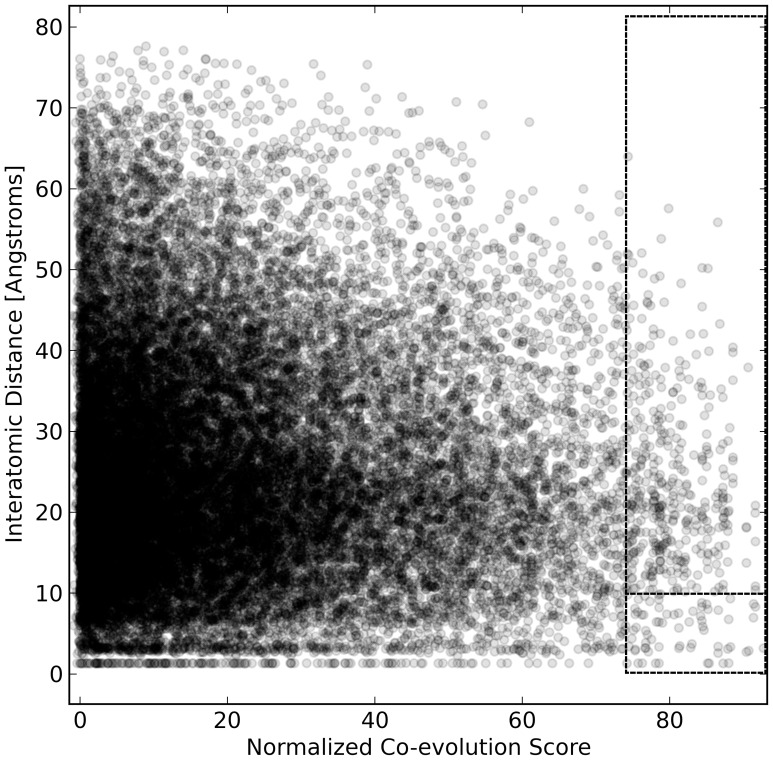
3D structural contacts do not correlate with co-evolution scores.The poor correlation between inter-atomic distance and (Z-normalized) co-evolution score is shown for one example subfamily/algorithm pair (PurR/ELSC). Points are plotted with 15% opacity to aid visual inspection. Highly co-evolving pairs of positions are often spatially distant (upper dotted-line box), rather than proximal (lower dotted-line box). Other subfamily/algorithm pairs show a similar absence of correlation (Figures S12–S17 in Data S3).